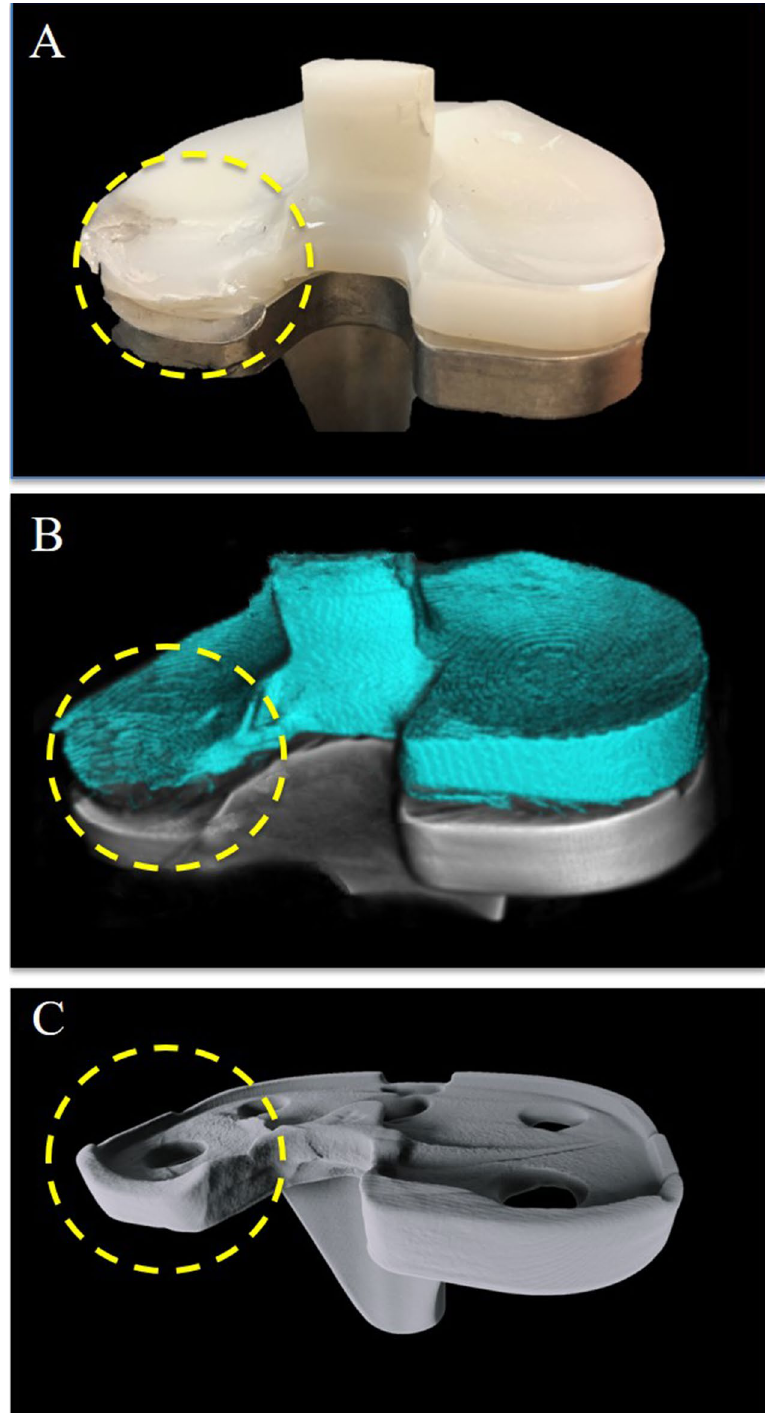
Figure 3. ( a ) Clinical photos, ( b ) MARS-CT images and ( c ) MARS-CT images with polyethelene digitally removed. The wear at the postomedial aspect of the polyethylene impant and tibial metallic tray is clearly visible